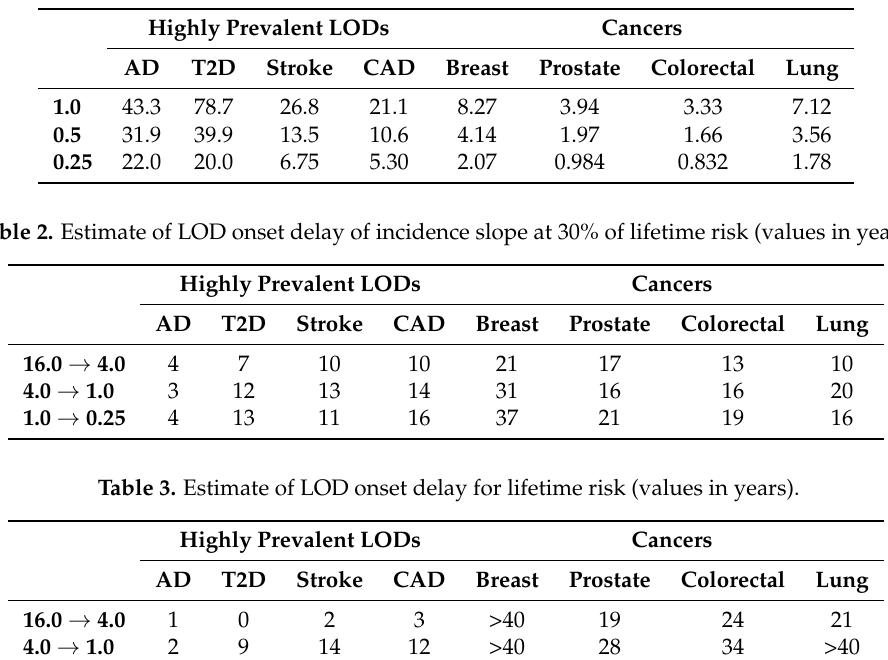
Table 1. Lifetime risk corresponding to select discrete LOD PRSs (%).